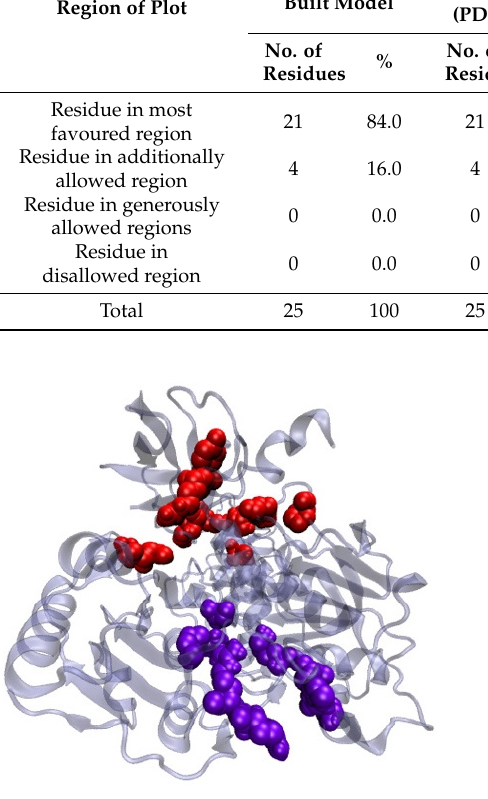
Table 3. Summary of molecular docking result, number of interactions involved for PlnE and PlnF .